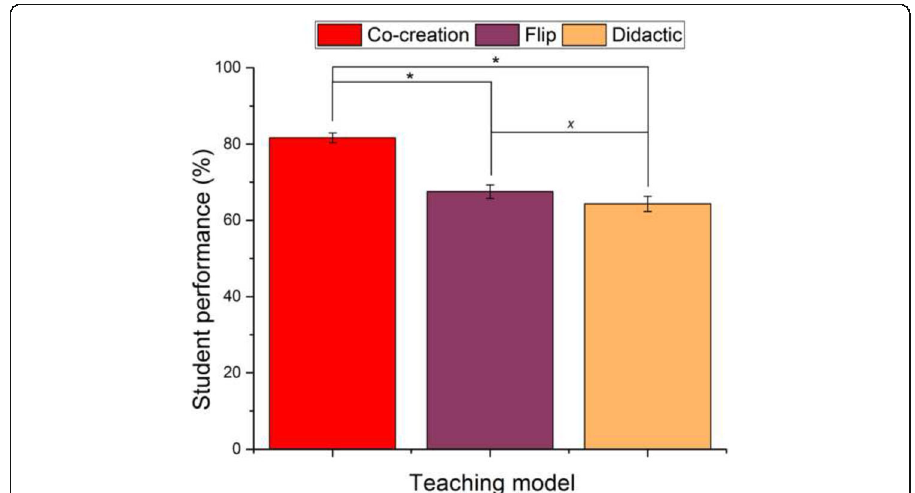
Fig. 6 Instructional outcome. Student performance on exams ( n = 8 participants × 15 items for each of the three methods) testing for content covered using the different teaching models implemented in the class. Data points are shown as averages with error bars representing the standard error of the mean. Statistically significant difference ( P <0.05) between different sample groups is marked with an asterisk. Statistically insignificant difference ( P >0.05) between different sample groups is marked with x